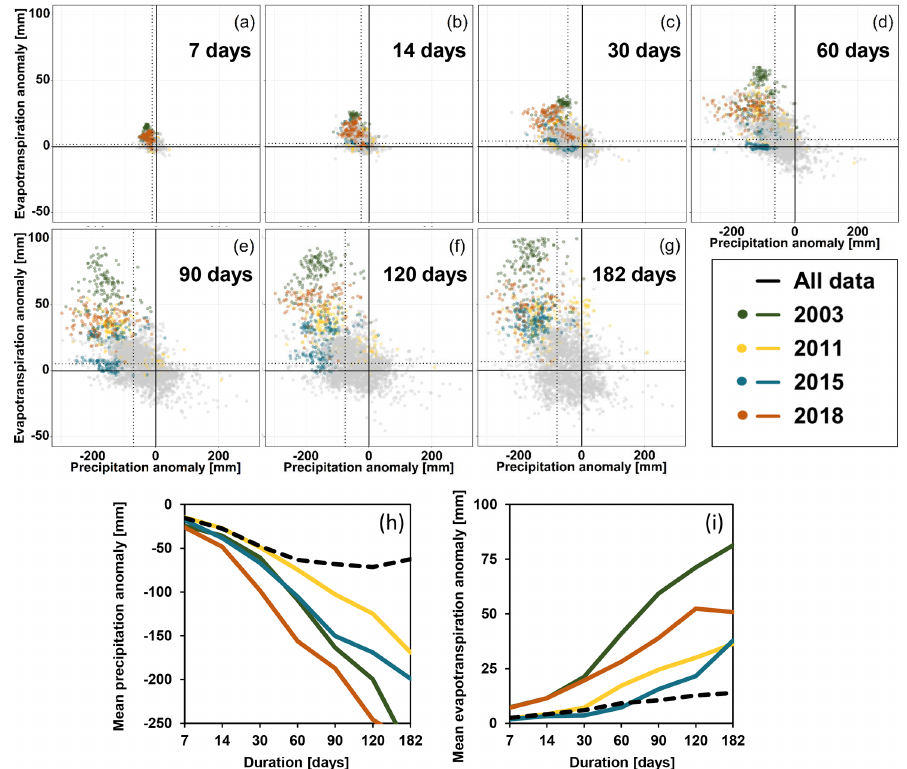
Figure 5. Cumulative anomalies of precipitation and potential evapotranspiration over 7, 14, 30, 60, 90, 120 and 182d prior to every annual warm-season low flow in each catchment (a–g) , and the evolution of the mean anomalies over the different time windows (h, i) . Each gray dot represents the combination of precipitation and E p anomalies before one low-flow event at one site. Low-flow anomalies in the most severe low-flow years are indicated by different colors (2003 in green, 2011 in yellow, 2015 in cyan and 2018 in orange). The dotted lines indicate the mean precipitation and E p anomalies. The mean anomalies (dotted lines in all panels) clearly increase within the first 60d prior to low flows but show no clear trend over longer time windows. During the most severe low-flow years, however, the mean anomalies continue to increase across all of the time windows examined here. In particular, the E p anomalies during the severe low-flow years grow well beyond the range that is observed during more typical